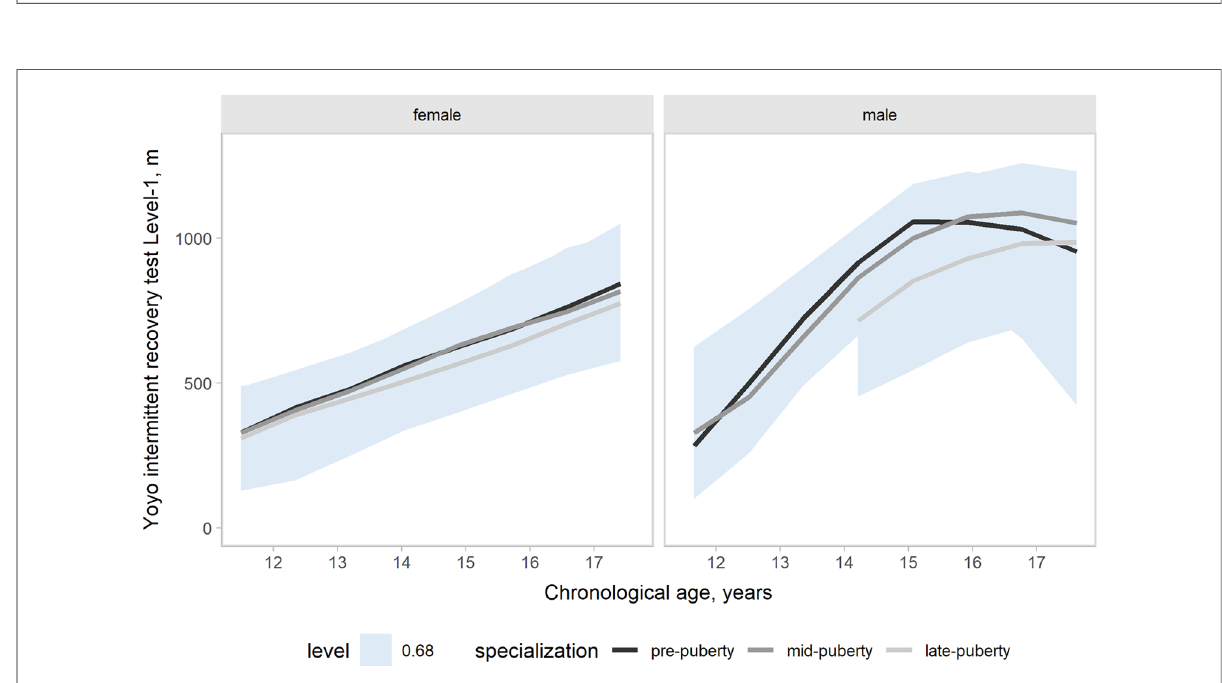
FIGURE 7 Developmental changes in Yo-yo intermittent recovery test level 1 performance for young females and male basketball players by specialization onset. The shaded area represents the 68% credible interval, similar to a standard deviation.